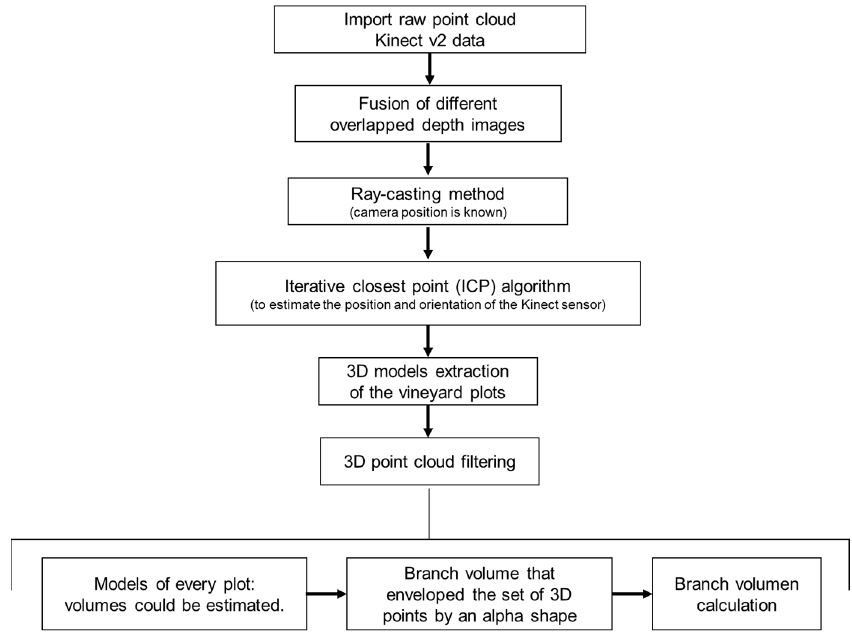
Figure 3. Data-processing block diagram.